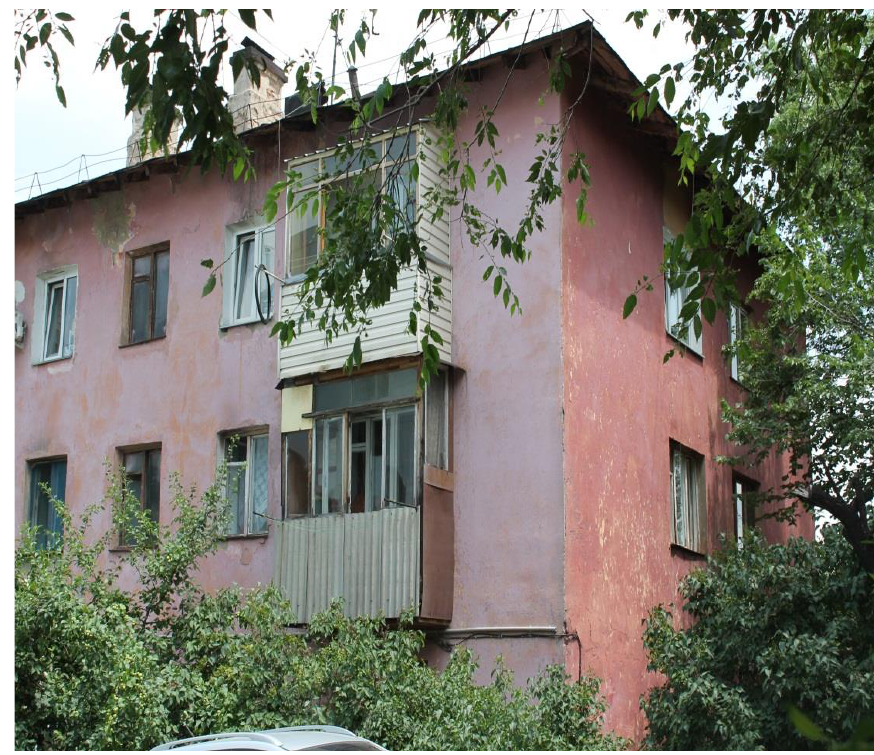
Figure A3. Unreinforced masonry with adobe bricks.